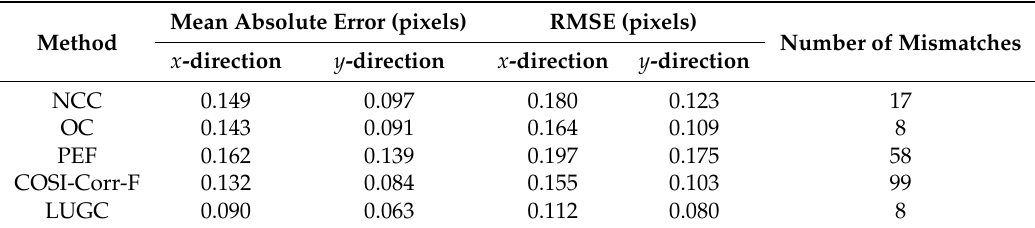
Table 3. Mean absolute error and RMSE of the matching results of different matching